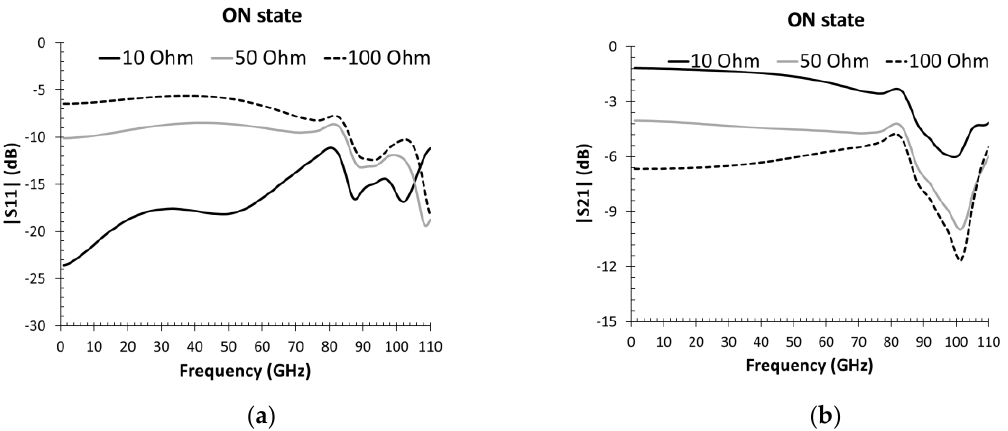
Figure 5. Degradation of memristor microwave switch properties (in ON-state) as a function of different values of R ON : ( a ) Reflection coefficient |S 11 |; ( b ) transmission coefficient |S 21 | [13].